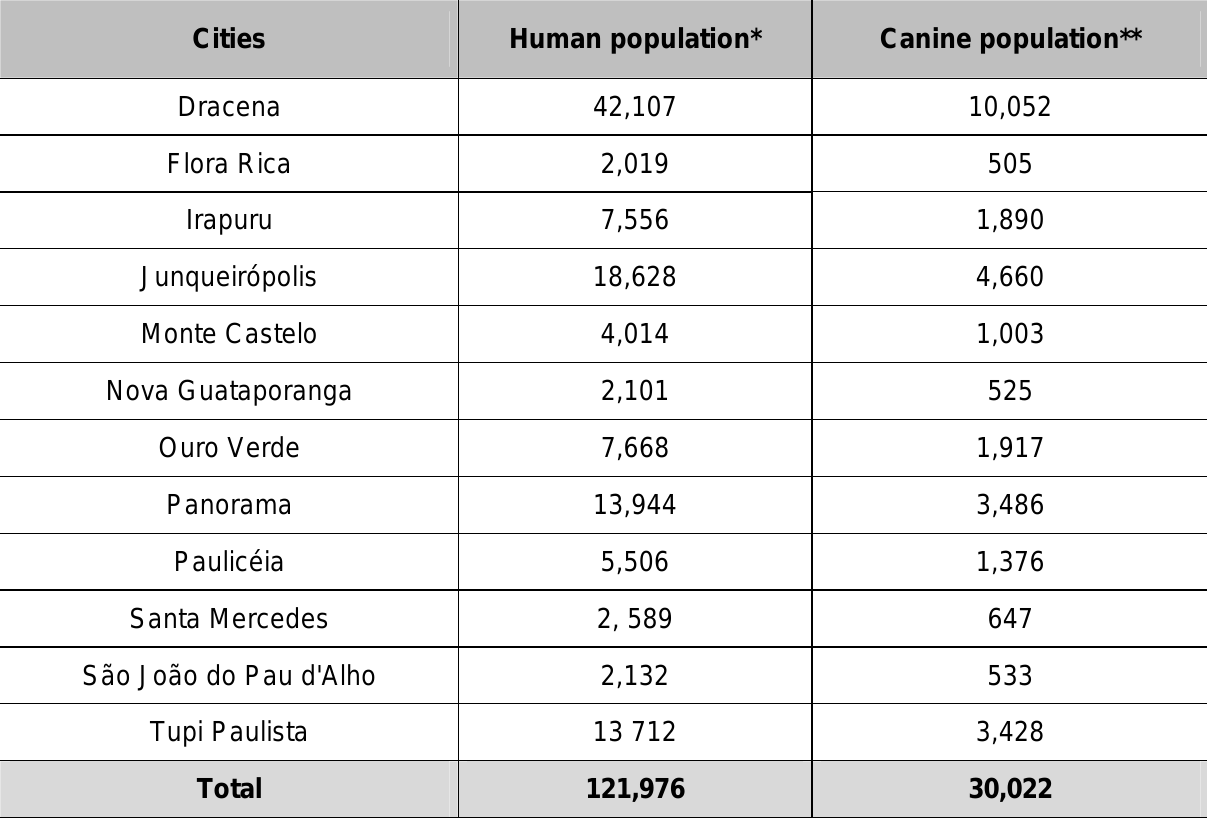
Table 1. Estimated distribution of human and canine population in